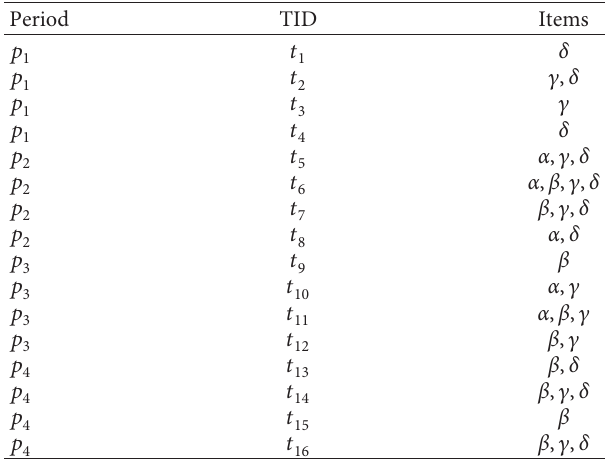
Table 1: An example of a temporal transaction data set. Period TID